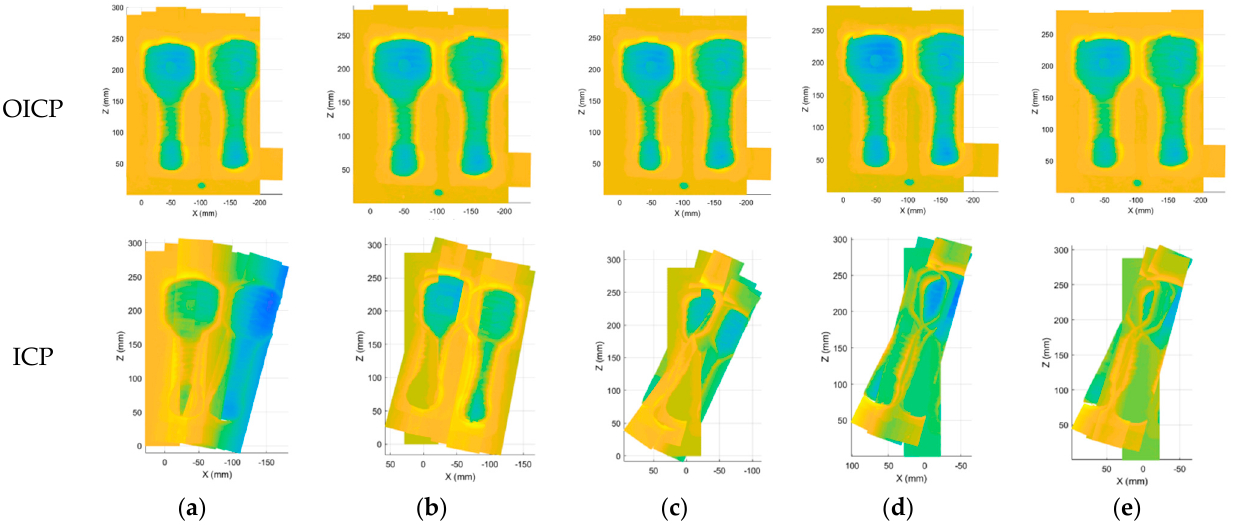
Figure 9. The effect of point cloud registration of ICP and OICP at a low overlap rate (<60%): overlap = ( a ) 50%; ( b ) 40%; ( c ) 30%; ( d ) 20%; ( e ) 10%.